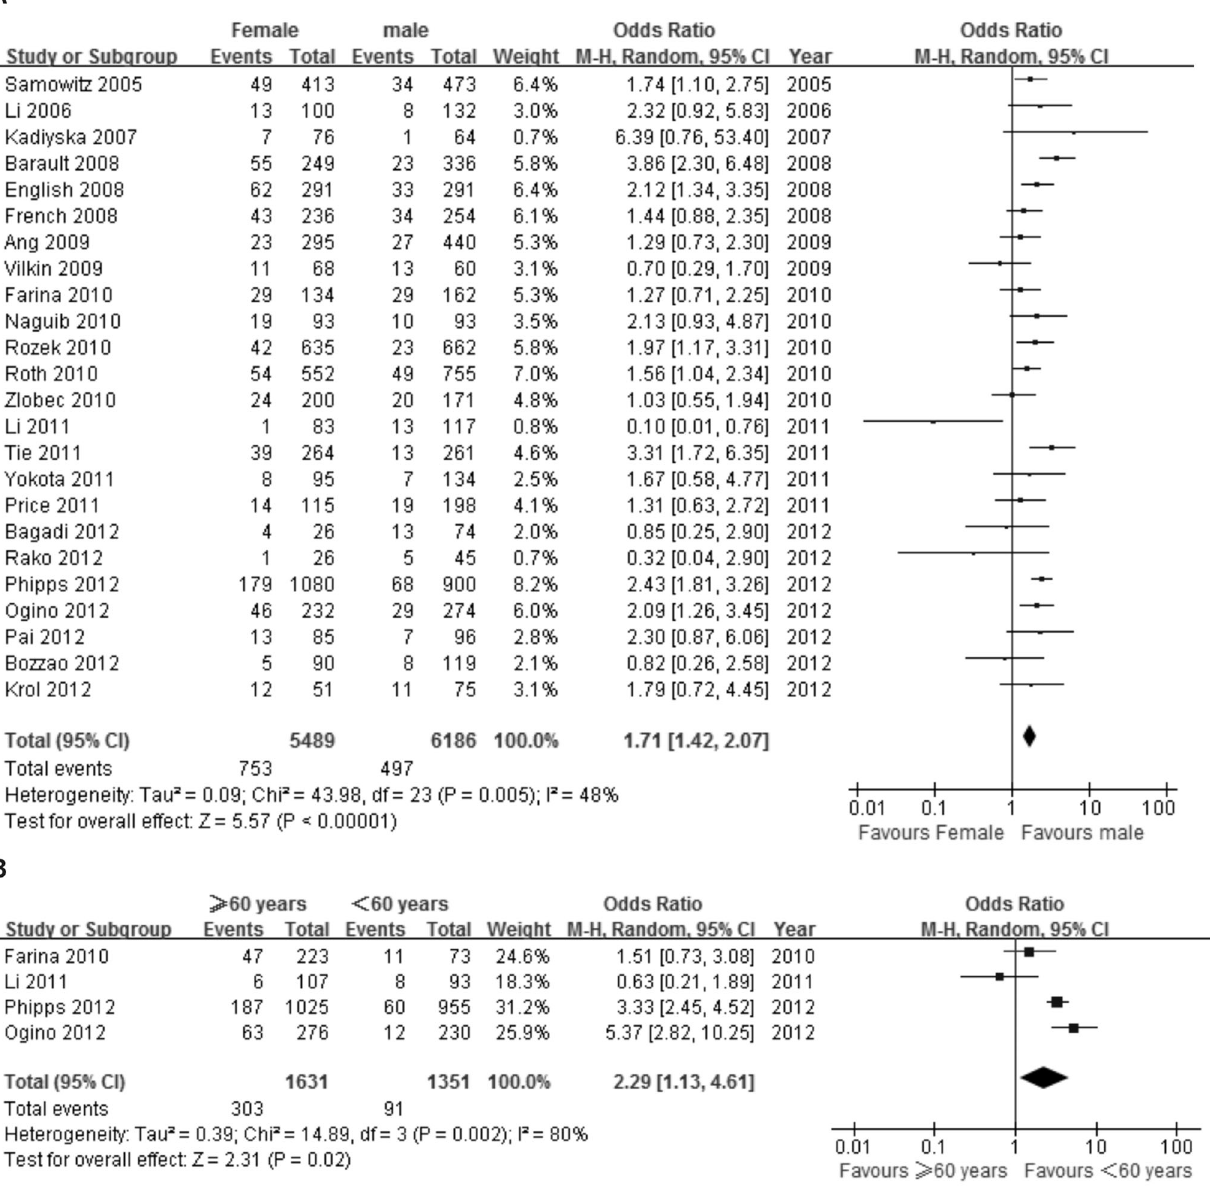
Figure 2. The association of BRAF V600E mutation with demographics. Random effects model of the odds ratios (ORs) with 95% confidence intervals (CIs) for the association of BRAF V600E mutation with gender (A) and age (B).